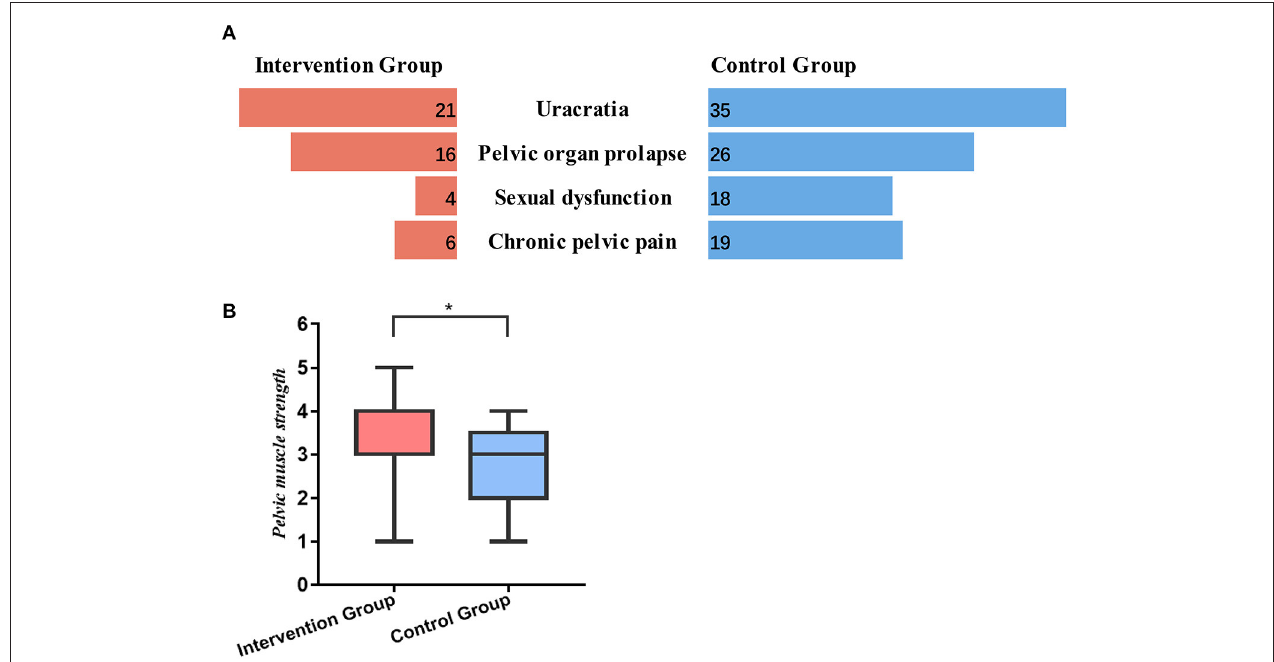
FIGURE 2 | The pelvic floor function of patients at 6-month follow-up. (A) The incidence of uracratia, pelvic organ prolapse, sexual dysfunction and chronic pelvic pain in intervention group and control group. (B) The pelvic floor muscle strength in intervention group and control group. *, p < 0.05.